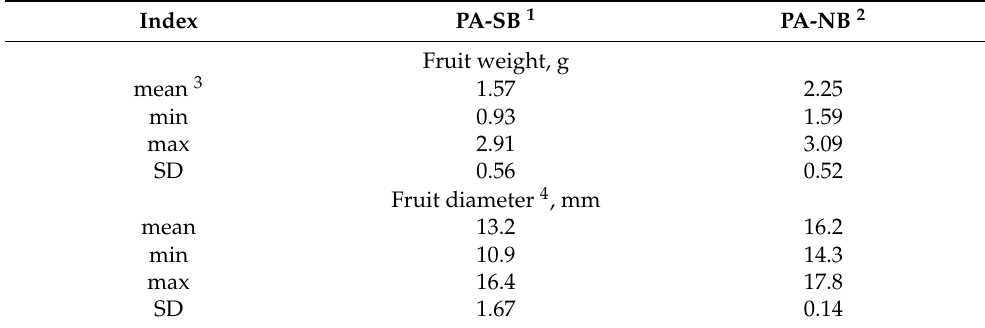
Table 1. Physical parameters of fresh Physalis alkekengi fruit.